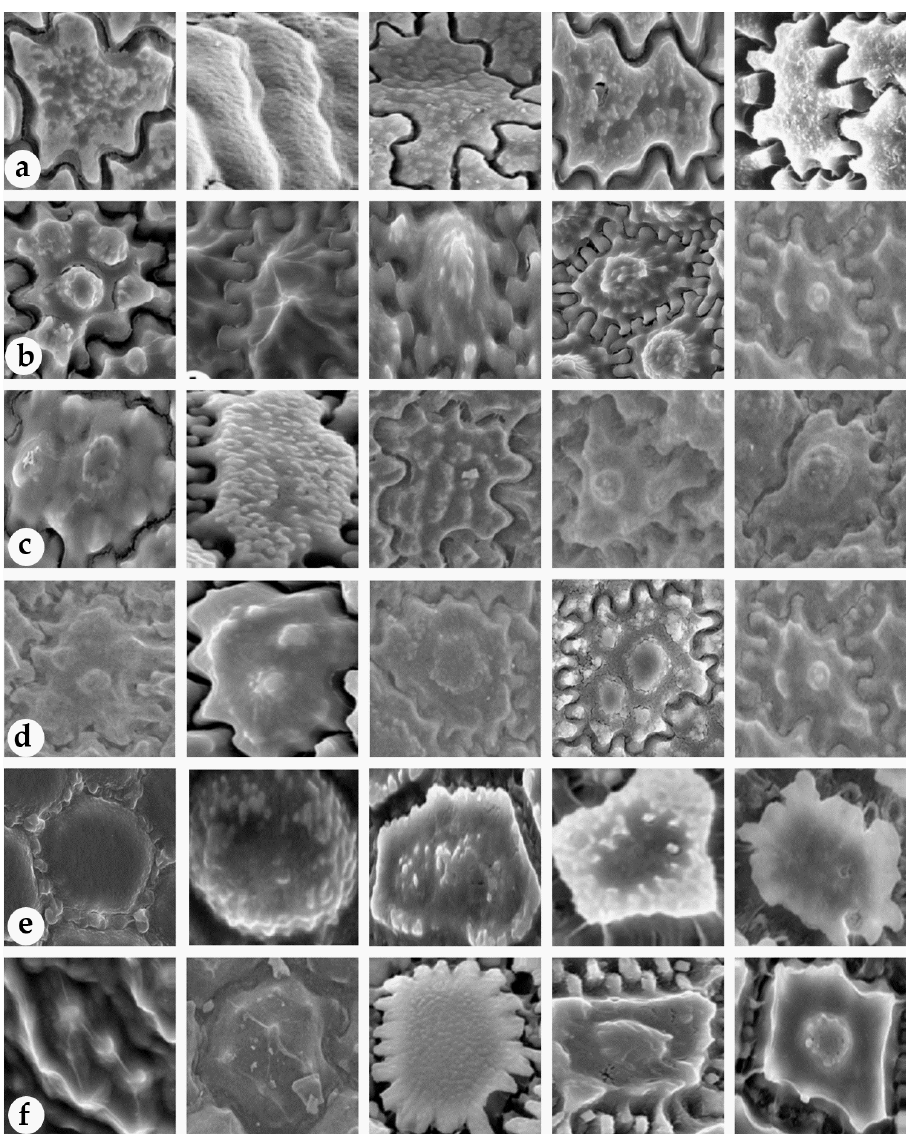
Figure 7. Related images for each group from [5]. ( a ) Actual images in SI, ( b ) Identical image in SS, ( c ) Similar image in SM, ( d ) Approximately similar image in NS, ( e ) Possibly similar image in PS, ( f ) Remaining images in PD.